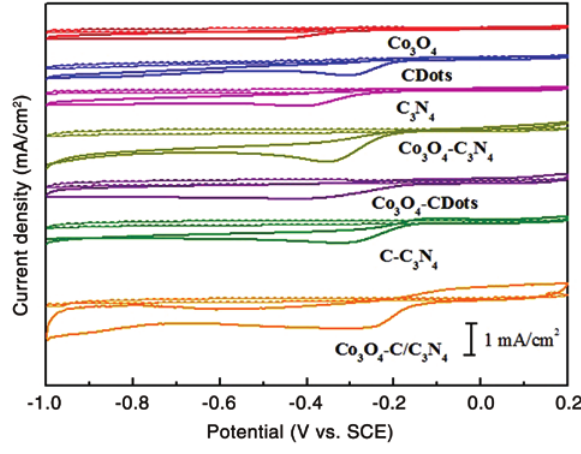
O , carbon nano- 3 4 O -C/C N in (solid 3 4 3 4